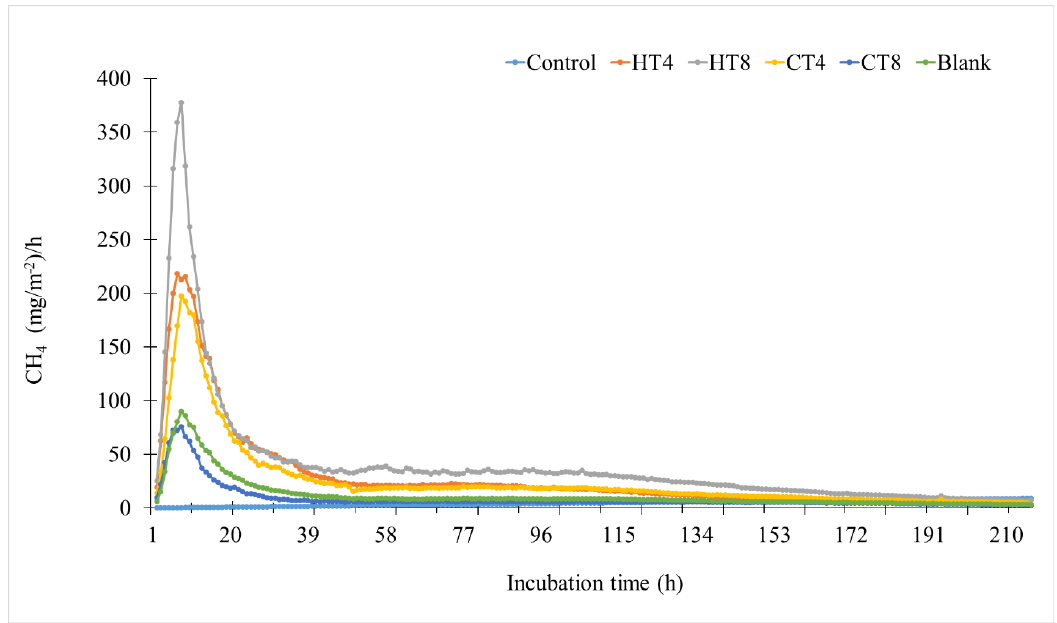
Figure 2. Hourly rates of methane emissions during in vitro incubation (n = 3) with dairy cattle manure composting. CT = quebracho condensed tannins; HT = chestnut hydrolysable tannins.